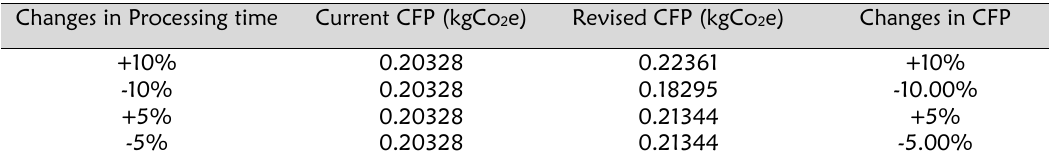
Table 5: Computed values for sensitivity analysis from the prospect of processing time.